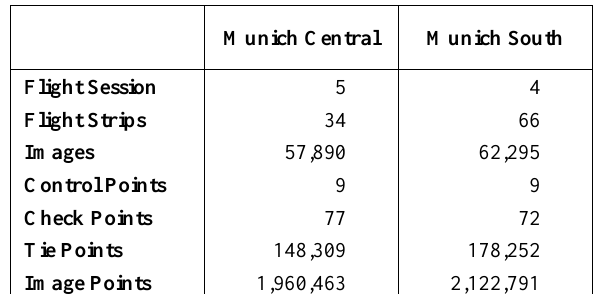
Figure 4. CBA difference between hierarchical and integrated AT for Munich Central. Color scale is -0.020 m to +0.020 m.